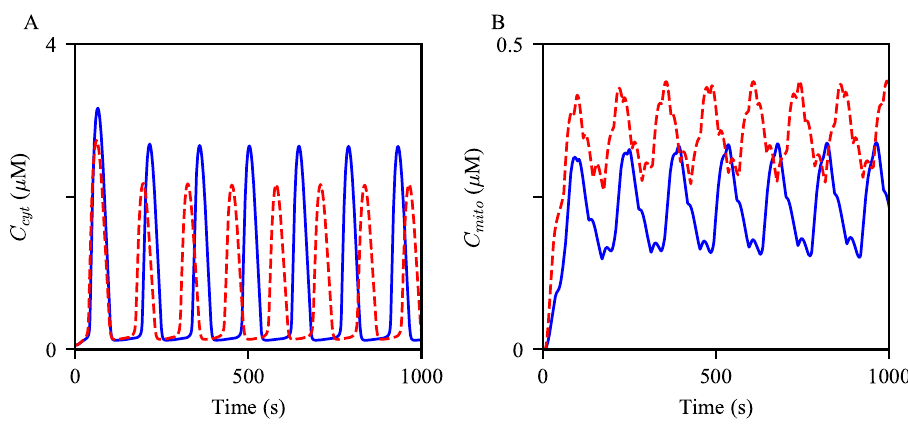
Fig 9. Effects of increased MAMs on Ca 2+ oscillations. Oscillations of (A) cytosolic and (B) mitochondrial Ca 2+ concentrations generated from the control model, in blue, and the model with the increased R S ’s, in red dashed. The model was given continuous stimulation of IP 3 with P s = 0.3 μ